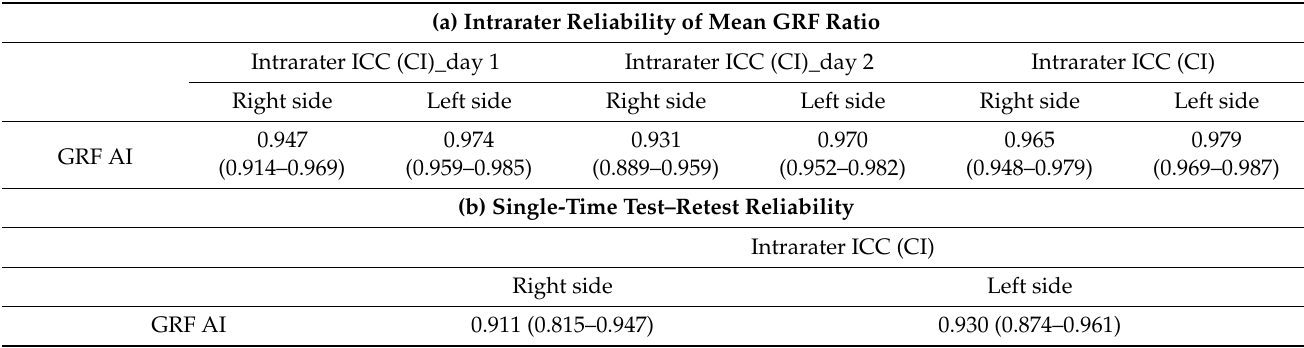
Table 3. Reliability of sit-to-stand test performance conducted two times 1 month apart ( n = 47). (a) Intrarater Reliability of Mean GRF Ratio